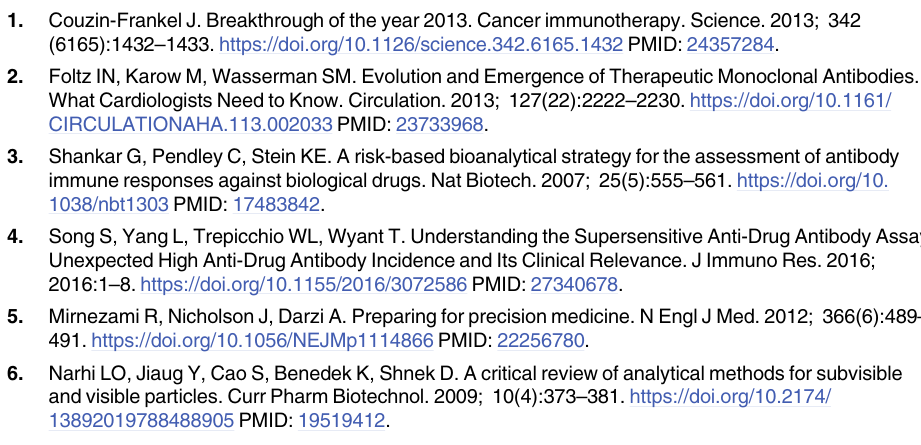
S1 Fig. Flowchart/block diagram of the methodology of this study. Polarization of GC-SPFS signal were basically evaluated by using Allophycocyanin. And next, we designed two evalua- tion step for GC-SPFS with and without optical B/F separation, first affinity analysis perfor- mance and second quantitative ligand binding assay performance.